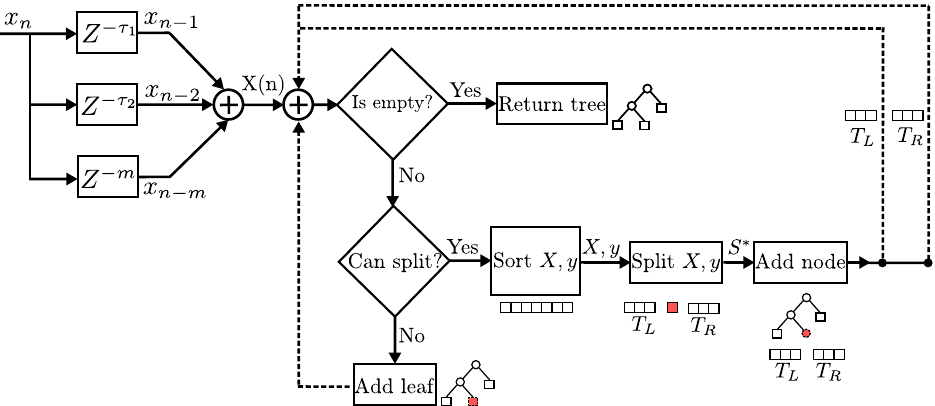
Figure 3. Block diagram of the construction process of a